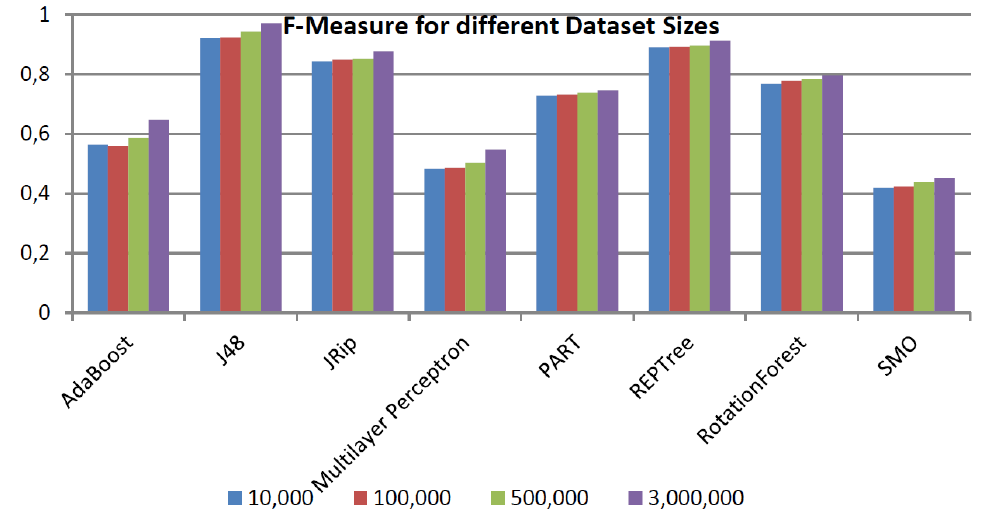
Figure 5. F-Measure of each classifier for predicting new purchases regarding the four selected datasets.